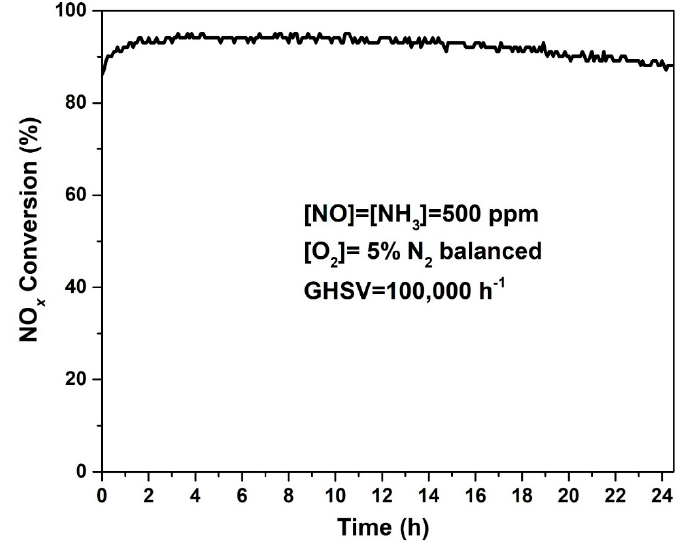
Figure 8. NH 3 -SCR activity test of 5% Mn/Cu-SSZ-13 at 135 °C for 24 h.